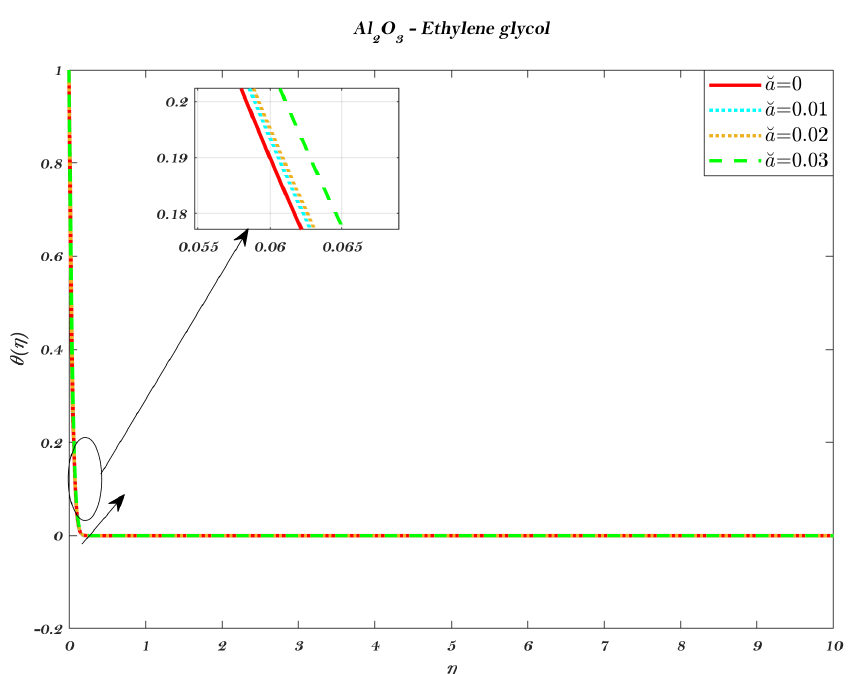
Figure 12. The slip parameters ˘ a against η on the temperature profile with ϕ = 2%, (cid:101) = 0.01 and R = 1.